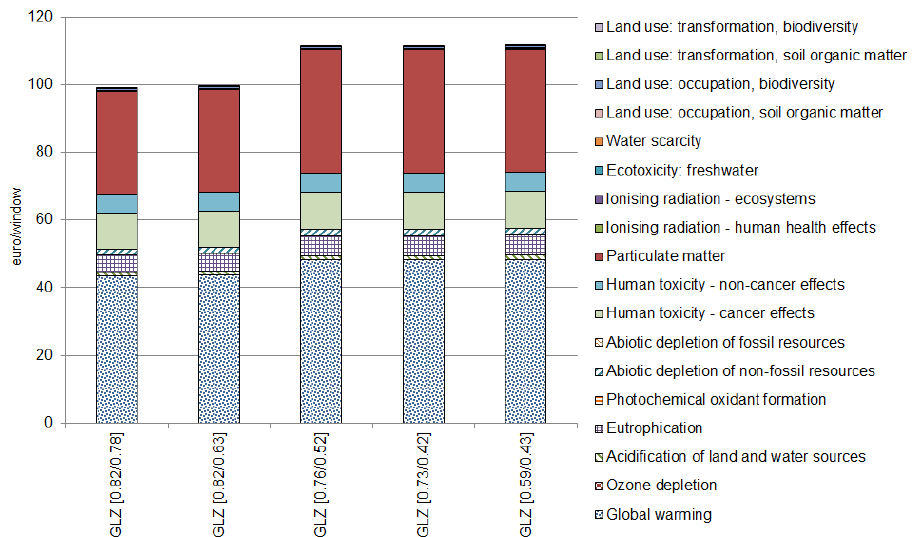
Fig. 6 Environmental impact of the window systems (4.80 m 2 window)